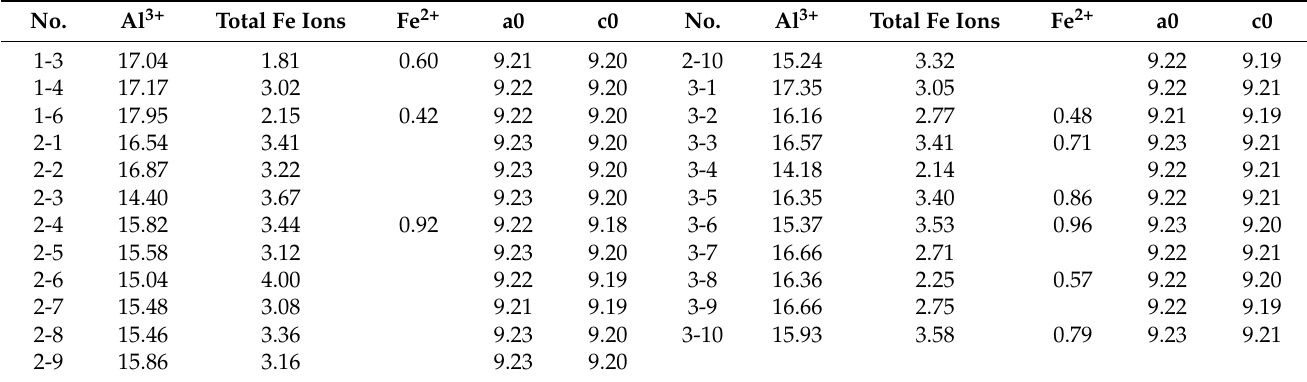
Table 2. Different ion content and cell parameters in 23 samples.